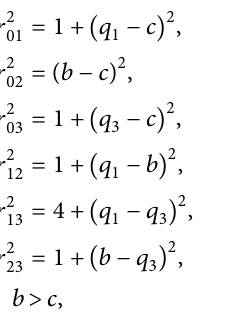
Figure 11: The progressive evolution of a Poincar´e surface of sections for different energy levels in the unequal masses case ( m � 0 . 31, m � m � 1, b � 1 . 1, and c � 0 . m 2 3 1